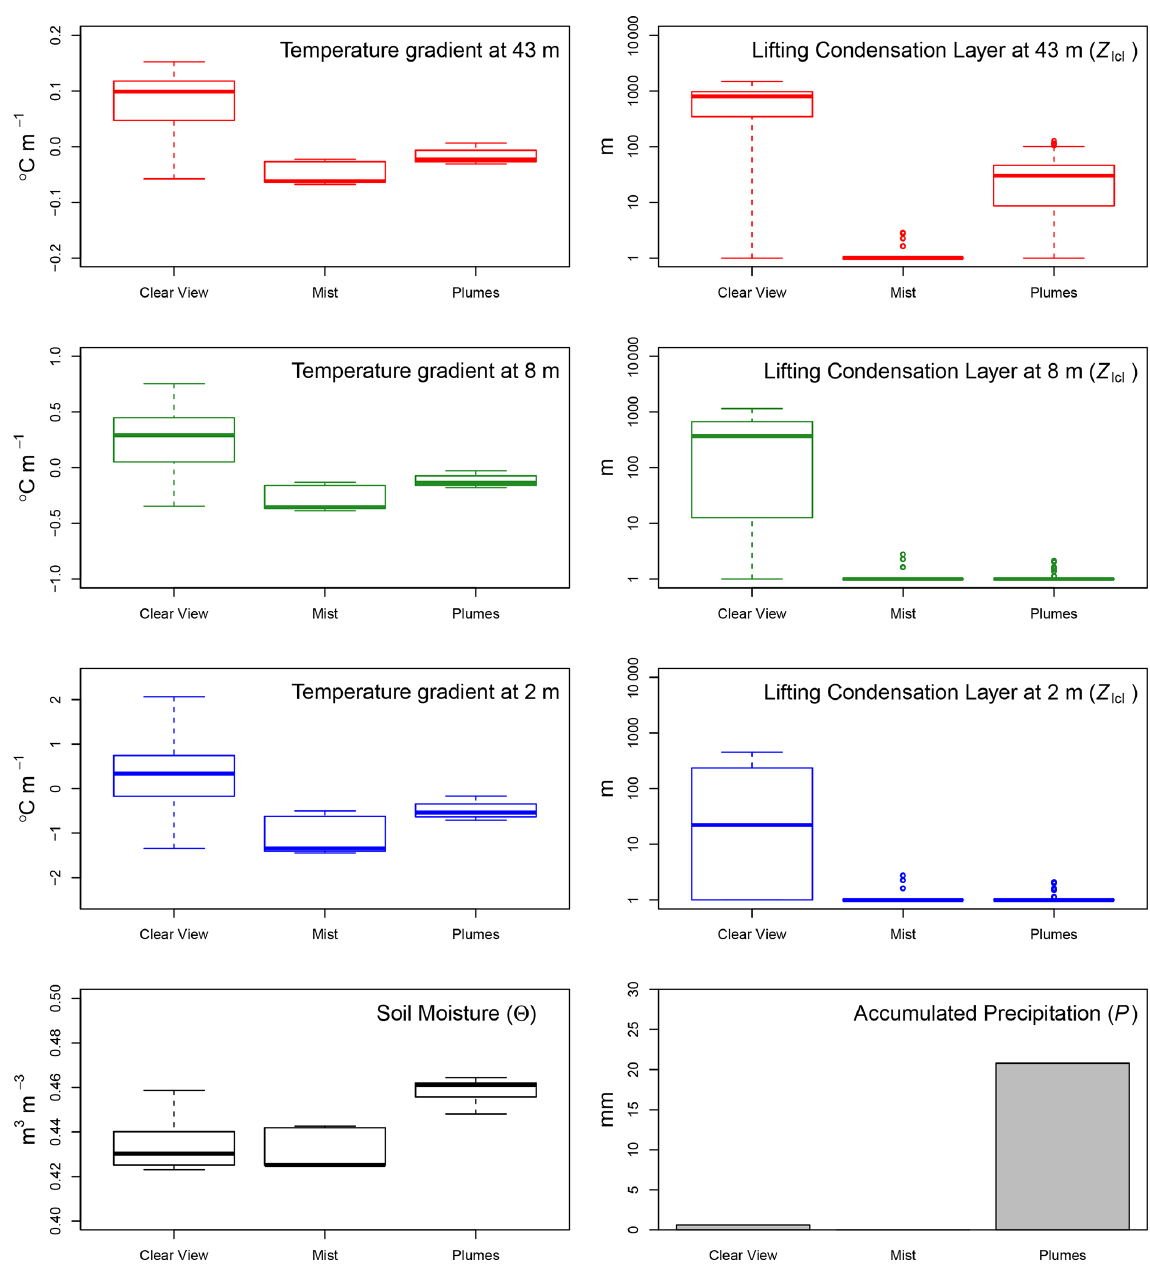
Figure C1. Boxplots describing the temperature gradients ( (cid:49)θ v ( (cid:50) ) and total precipitation ( P ) of the three visual categories evaluated.